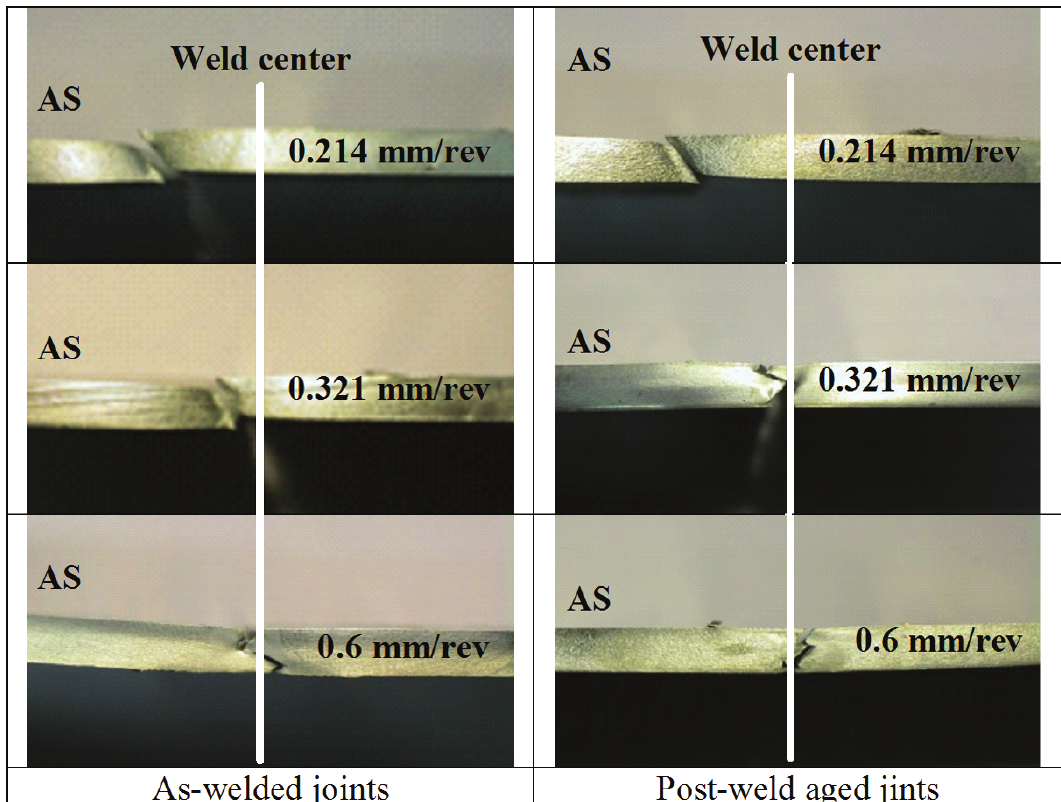
Figure 5. Typical fracture locations of the as-welded and post-weld aged joints.